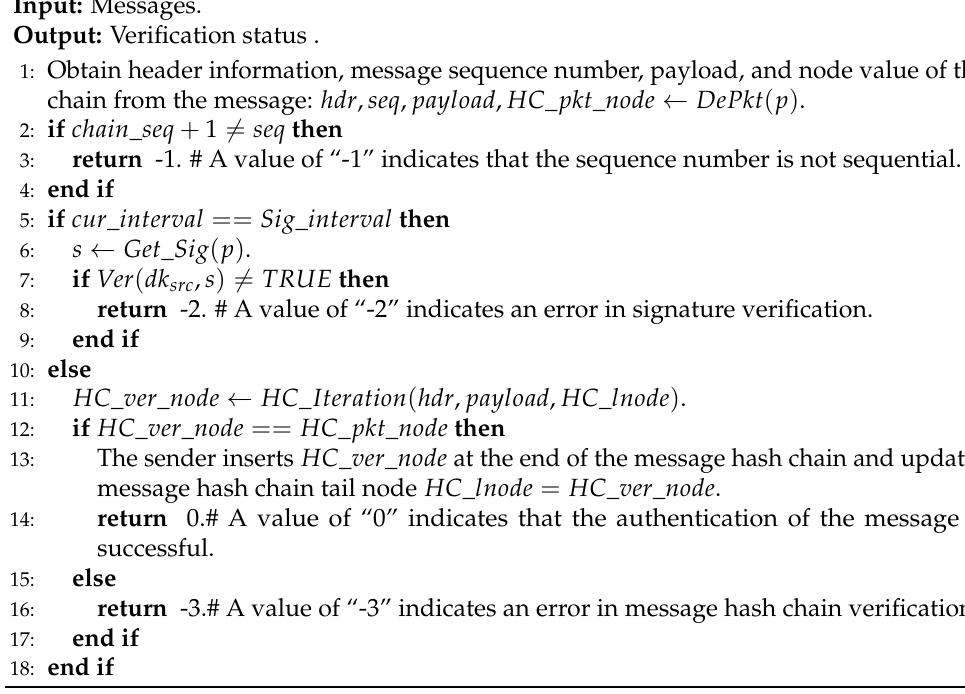
Algorithm 4 The Receiver Verifying The Received